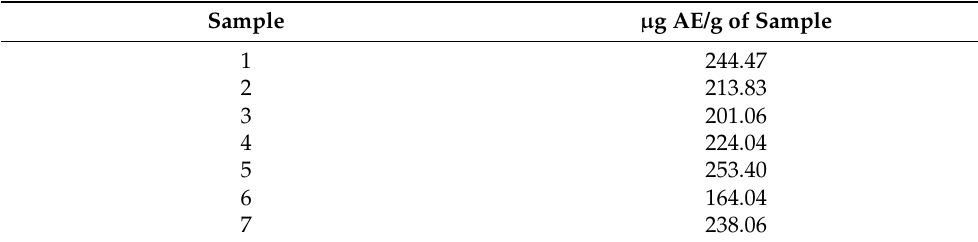
Table 12. Results expressed in µ g AE/g of sample (FRAP